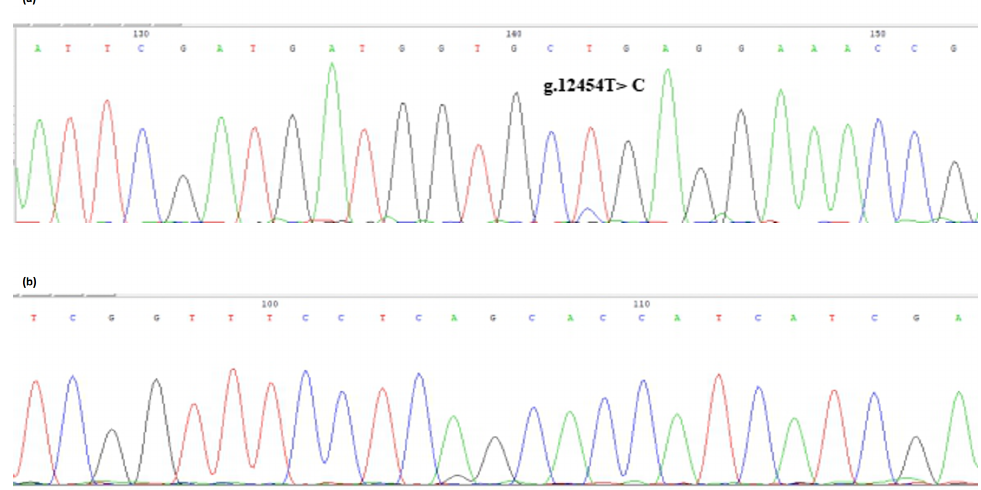
Figure 1. Sequencing of the SNP of cattle SPARC gene. Note that the sequence test is the SPARC (exon 4) in Chinese cattle DNA pool. (a) Forward sequencing; (b) reverse sequencing. Table 2. Genetic parameters of SPARC gene in four cattle populations. Breeds Number Genotypic frequencies Allelic frequencies Diversity parameters CC CT